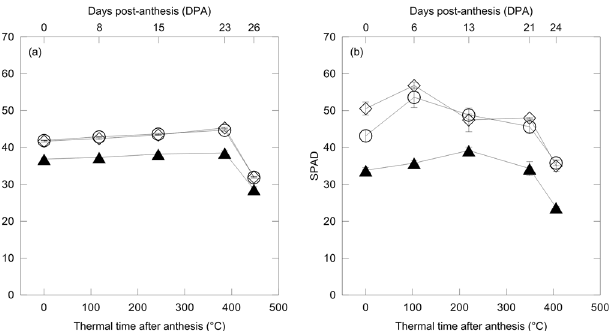
Fig 5. Changes of soil-plant analysis development (SPAD) against thermal time after anthesis (cumulative average daily air temperature exceeding 0°C, °C d) and days post-anthesis (DPA) (above axis) of durum wheat in 2011 (a) and 2012 (b). Wheat plants were exposed to control conditions (unfertilized CONTROL, black triangle) and to N fertilization treatments with urea (UREA, white rhombus) and calcium nitrate (NITRATE, white circle) at the rate of 150 kg N ha -1 (mean value ± standard errors, n = 3 independent replicates; split-plot ANOVA over thermal time after anthesis; effects: (a) treatment , P < 0.01; time , P < 0.01; treatment x time , P < 0.05; (b) treatment , P < 0.01; time , P < 0.01; treatment x time , P <